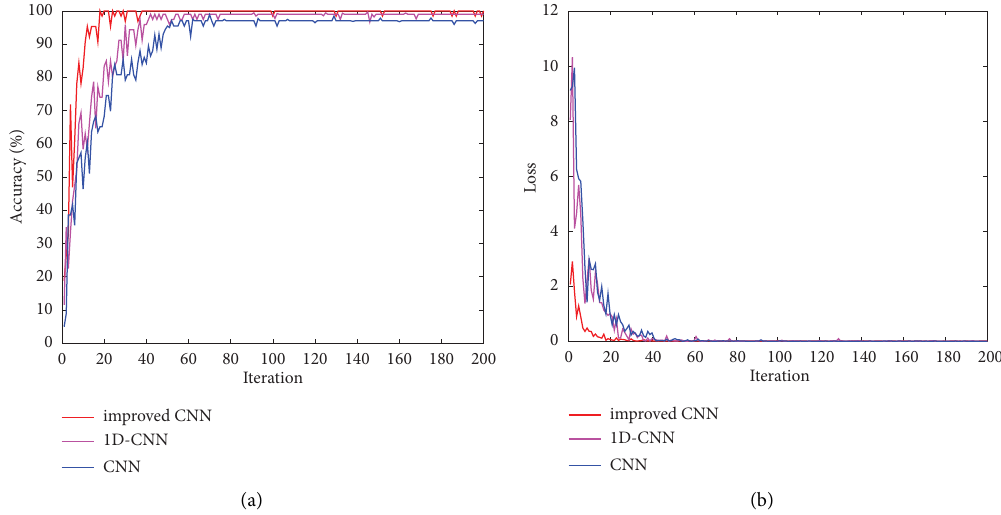
Figue 6: Curves of training result. (a) Te curve of accuracy and (b) the curve of loss.